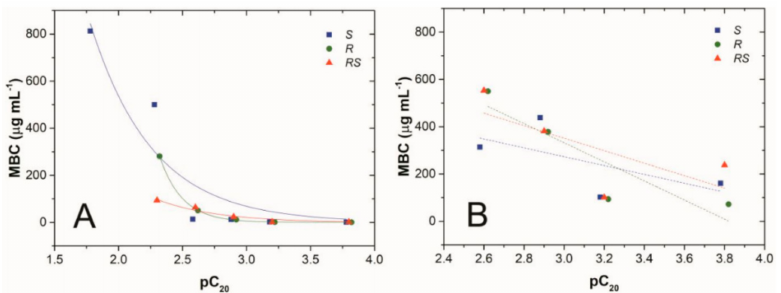
Figure 8. Relationships between adsorption efficiency (pC20) and mean values of MBC towards Gram-positive bacteria ( A ), Gram-negative bacteria ( B ) with (S)-mandelate, (R)-mandelate, and (RS)-mandelate anions